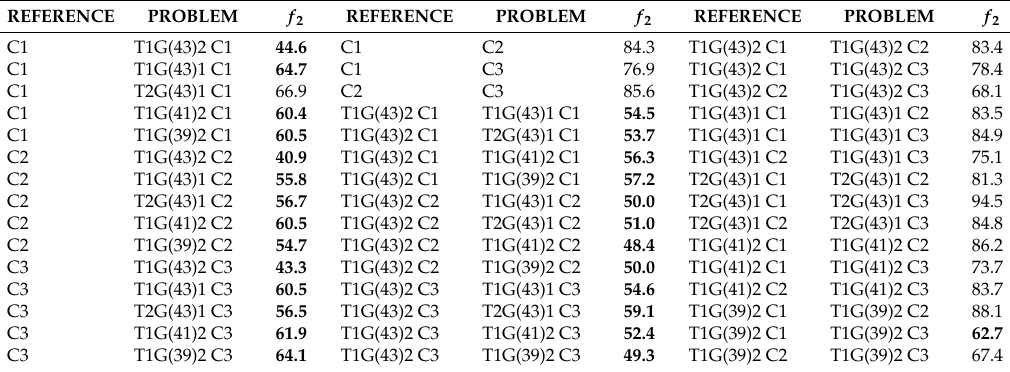
Table 3. Similarity factor ( f 2 ) values for the release profiles obtained from reference and problem formulations. Comparisons with significant difference ( f 2 < 65) are in